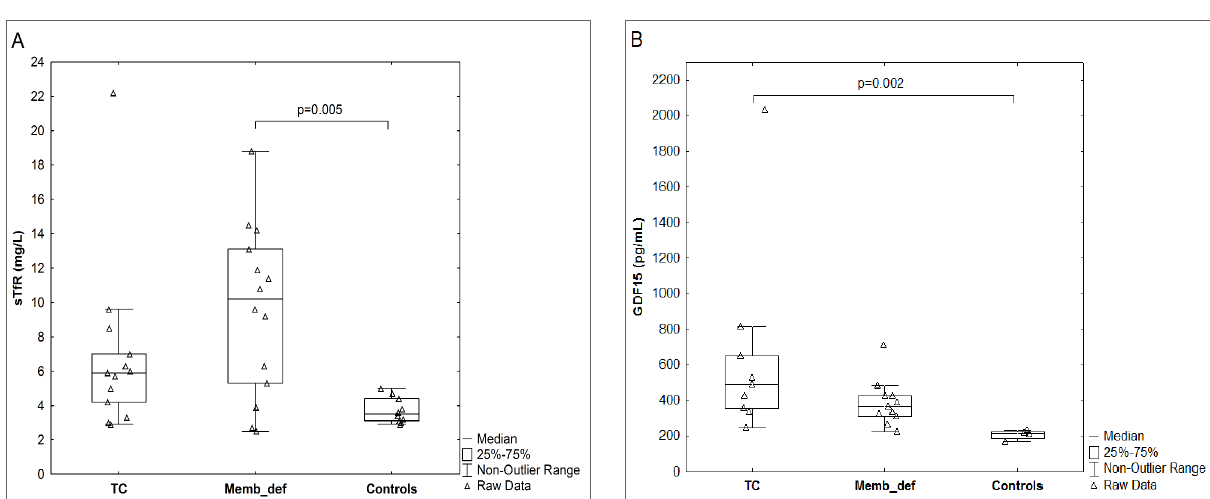
Fig. 1. Elevated markers of erythropoietic activity. (A) sTfR was increased in both patients’ groups when compared to the controls (n=9), but only in patients with erythrocyte membrane defect (Memb_def; n=14) the difference reached statistical significance; thalassemia carriers (TC, n=13). (B) The elevation of GDF15 in comparison to the controls was significant for TC (n=9), but not for Memb_def (n=11). sTfR, soluble transferrin receptor; GDF15, growth differentiation factor 15. The graphs show individual values (triangles), 25-75% range with median (box and horizontal line, respectively) and the non-outlier range (the highest and the lowest whiskers, respectively).